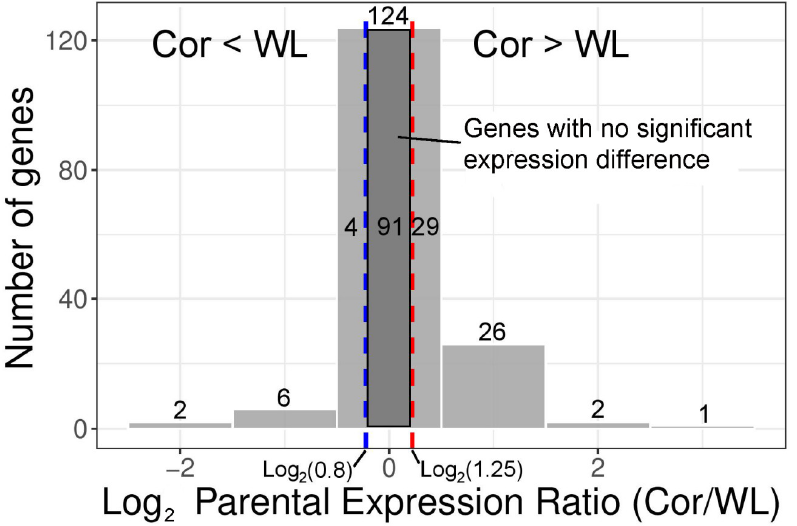
Figure 3. Differences in gene expression between Cor and WL. The histogram shows the direction and magnitude of changes in the expression in genes exhibiting divergent parental expression. The two vertical dashed lines represent the expression thresholds of parental divergence. Negative values indicate up-regulated expression of WL, and positive values indicate up-regulated expression of Cor. Table 1. The number of regulatory divergence categories of W-linked genes in three tissues.